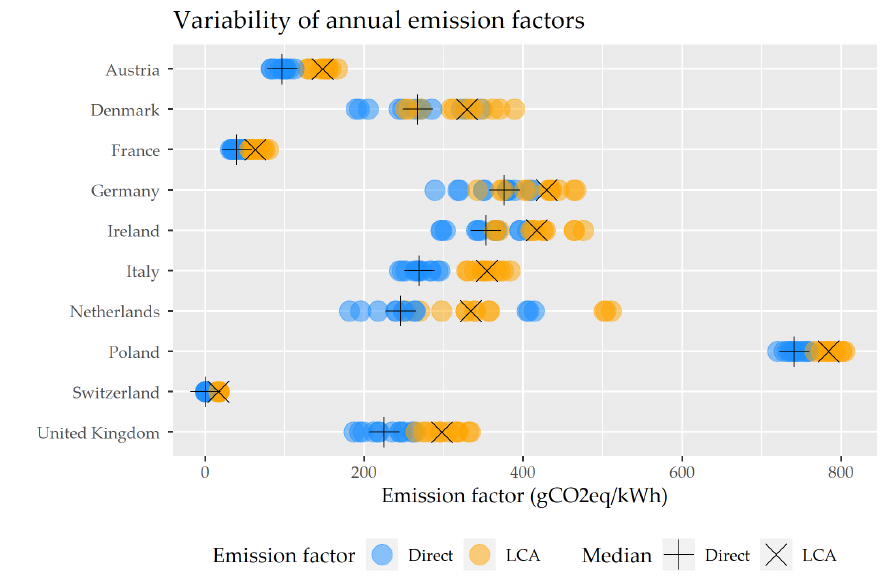
Figure 5. Variability of annual emission factors of EV charging in each country (with variable year and charging profile). Table 2. Variation of annual emission factors over charging profile and years for each country g CO2eq /kWh el Direct Emission Factor LCA Emission Factor Mean Min Max Range vs. Mean Mean Min Max Range vs.